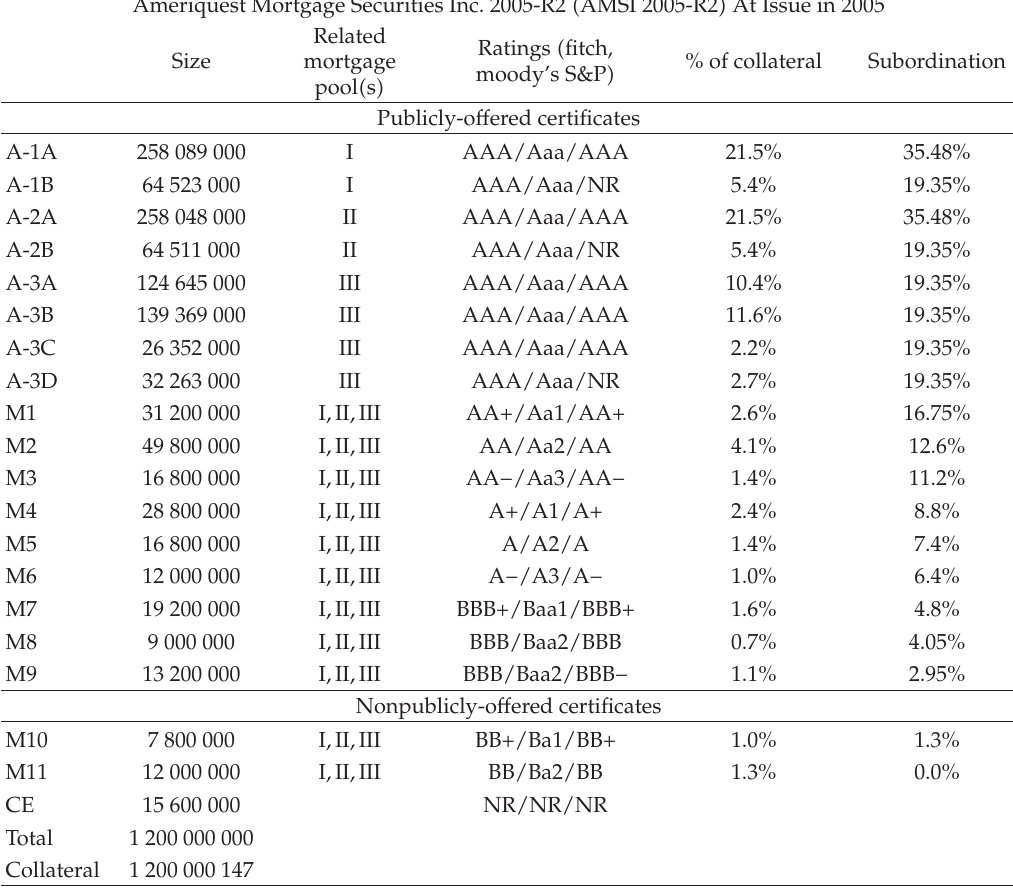
Table 8: Ameriquest Mortgage Securities Inc. 2005-R2 (cid:2) AMSI 2005-R2 (cid:3) at Issue in 2005; source: (cid:6) 26 (cid:7)